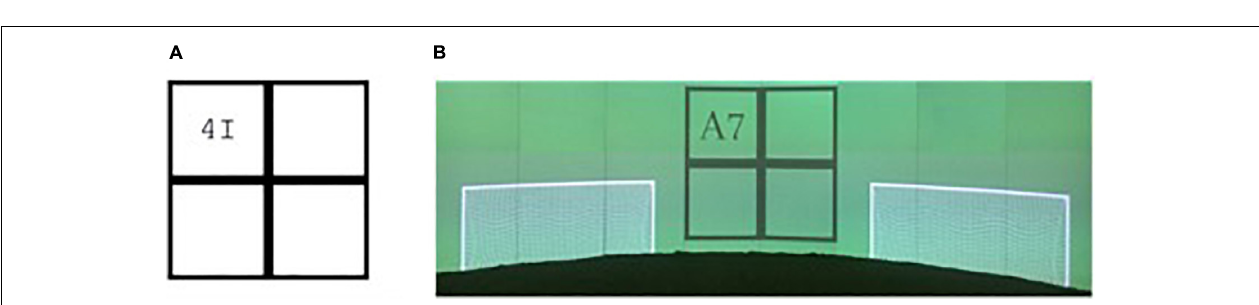
FIGURE 1 | Flanker task for the computerized (A) , adapted for the SoccerBot360 (B) and after revision in SoccerBot100 (C) . Images of SoccerBot reproduced with permission from Umbrella Software.